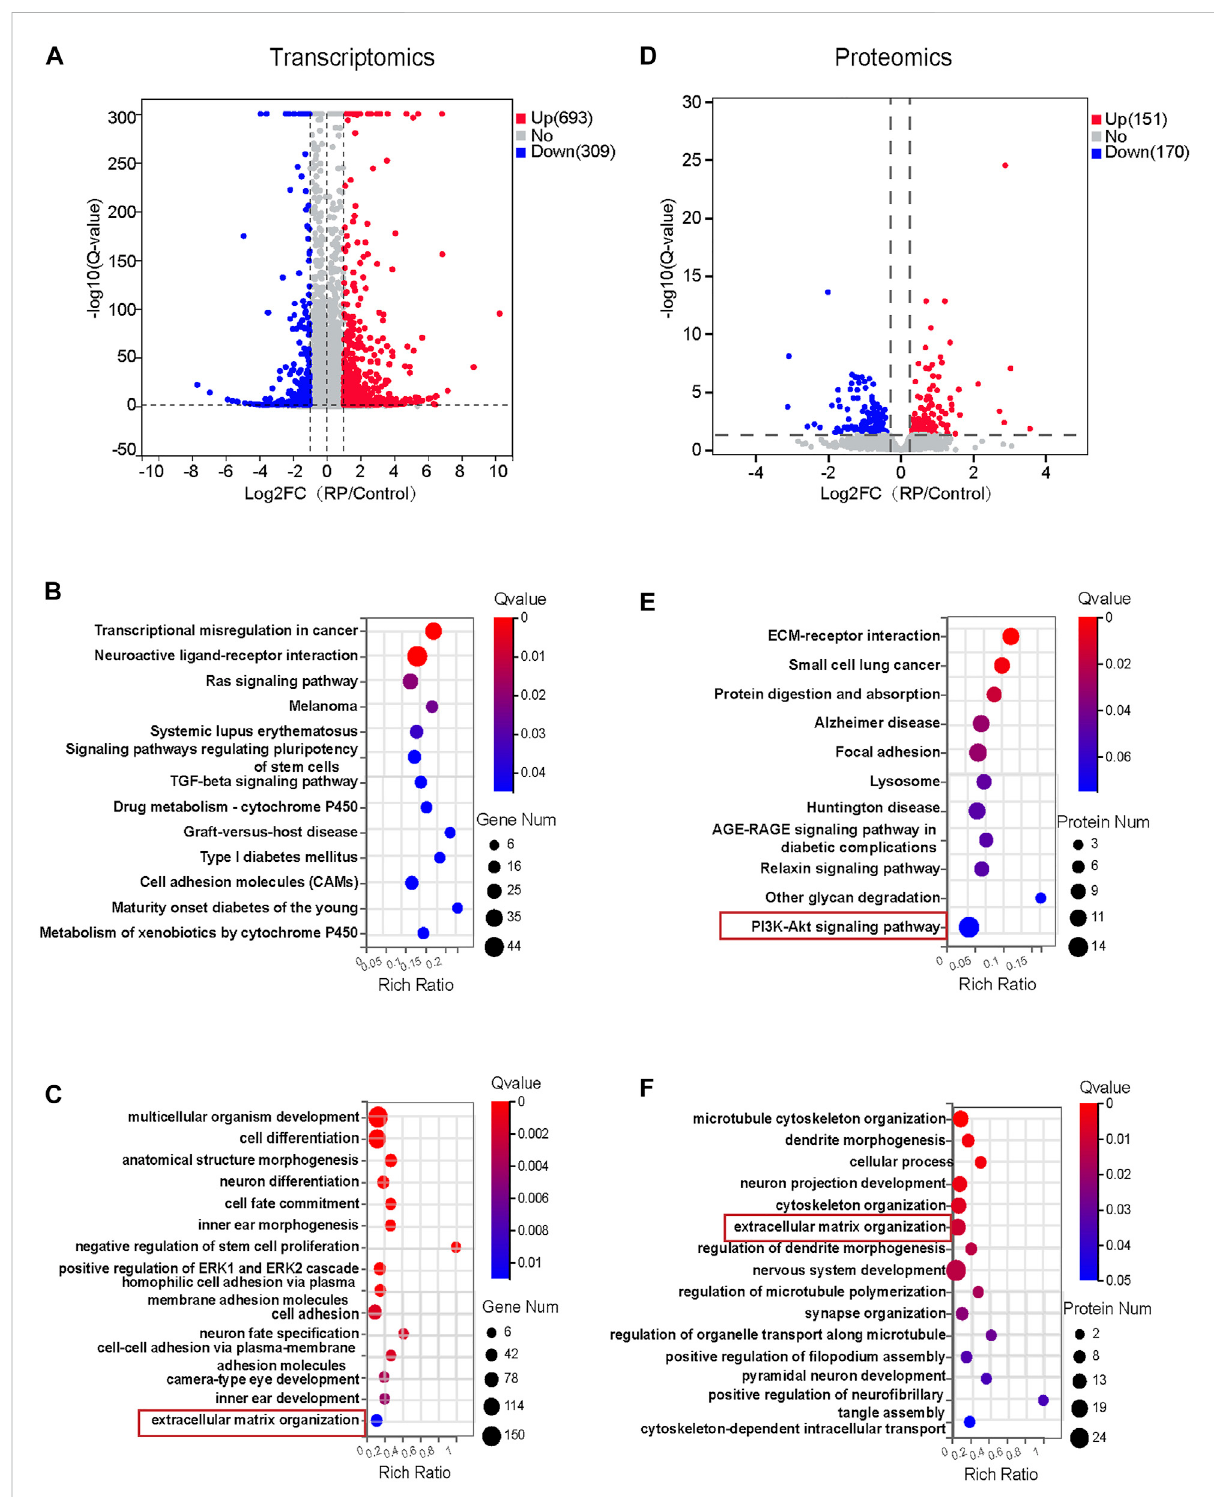
FIGURE 3 Transcriptomics and proteomics analysis for early ROs with USH2A mutations. (A) Volcano plot showing 693 DEGs were upregulated and 309 DEGs were downregulated in the RP group. (B) The 13 signi fi cantly changed signaling pathways based on DEGs in the RP group. (C) The 15 GO biological process terms based on DEGs. (D) Volcano plot showing 422 differentially expressed proteins, 151 proteins were upregulated and 170 proteinswere downregulated. (E) The 11 signi fi cantly changed signaling pathwaysbased on differentially expressed proteins. (F) The 15 GO biological process terms based on up-regulated and down-regulated proteins were